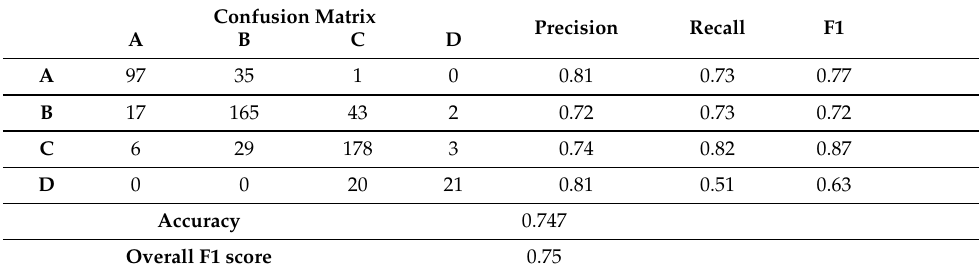
Table 15. Average ensembles.